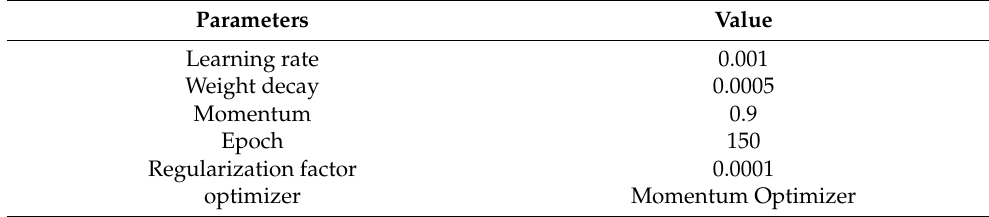
Table 1. Training parameters of Faster R-CNN.